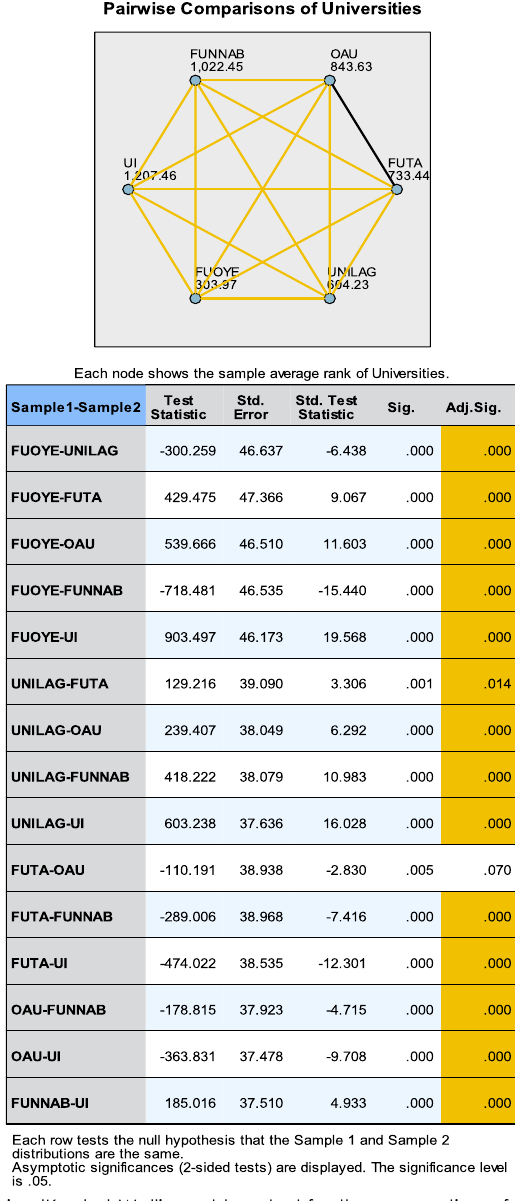
Figure 2. Result of a Pairwise customisedKruskal-Wallis post-hoc test for the perception of Quality of Zoological gardens in the study